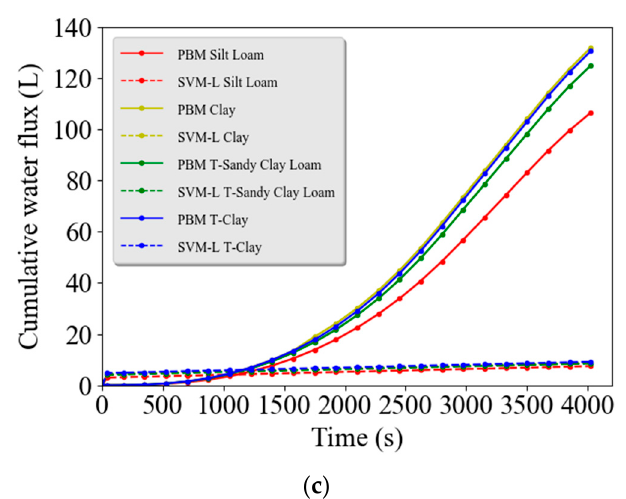
Figure 4. Comparison of cumulative water fluxes ( Q c in liters, L) calculated by the PBM and the Linear Support Vector Machine (SVM-L) model (( a ) overall, ( b ) different initial water contents, ( c ) different textures)).